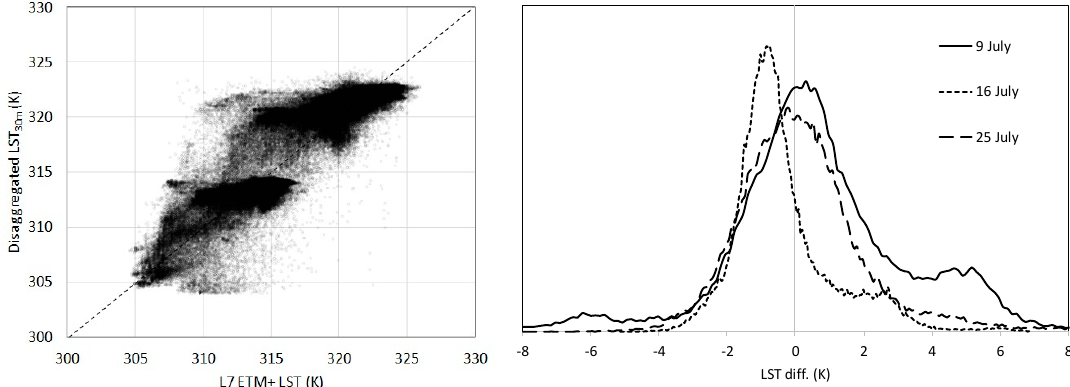
Figure 9. Disaggregated LST 30m versus L7-ETM + LST for the full dataset (left). Dashed line represents the 1:1 agreement. Histograms of pixel-to-pixel differences between disaggregated LST 30m products and LST estimates from L7-ETM + images for three concurrent MODIS and Landsat-7 overpasses